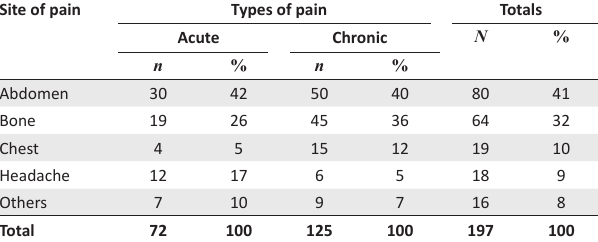
Table 3. Dermatitis and emesis were the most frequent cancer treatment-related side-effects that prompted unplanned attendances (Table 4).